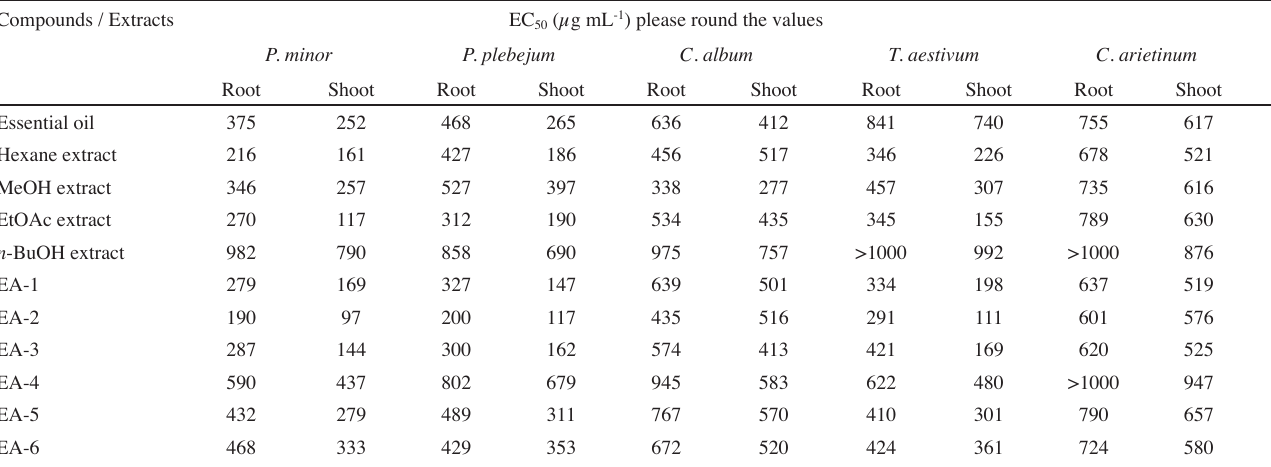
Tab. 2: Plant growth inhibitory activity of extracts and cadinene sesquiterpenes. Compounds / Extracts EC 50 (µg mL -1 ) please round the values P.